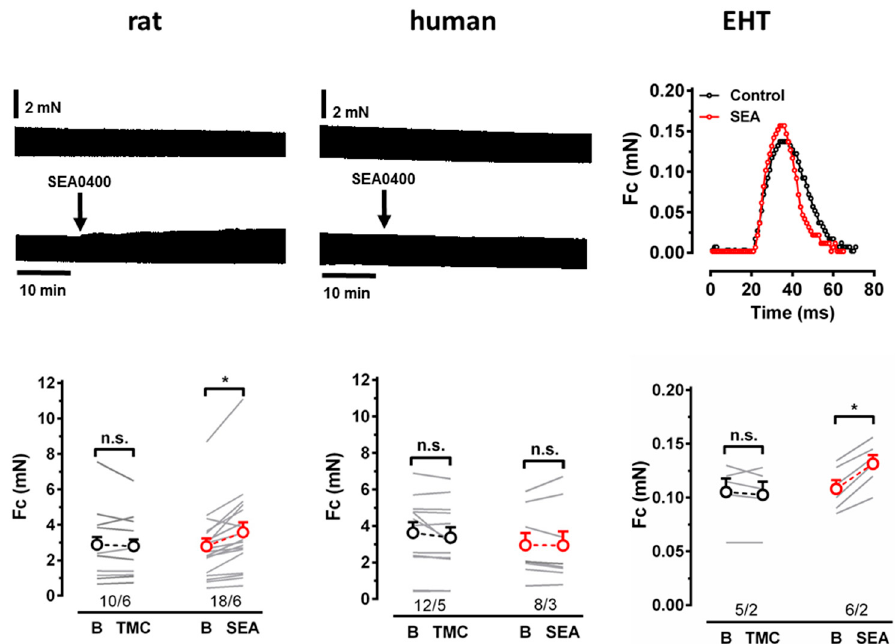
Figure 3. Force measurements in rat ventricle, human ventricle, and EHT. ( Up ) Time course of force in rat and human ventricle given as time-matched controls (TMCs) and exposed to 10 µM SEA0400. Single contraction of force in EHT given as TMCs and exposed to 10 µM SEA0400. ( Bottom ) Individual data points (light gray) and respective mean values ± SEM for force given as time-matched controls (TMCs) and in the presence of 10 µ M SEA0400 in rat ventricle, human ventricle, and EHT. n/n indicates the number of cells/number rats or humans and the number of cells/number of isolations for EHT, * indicates significance, n.s. indicates